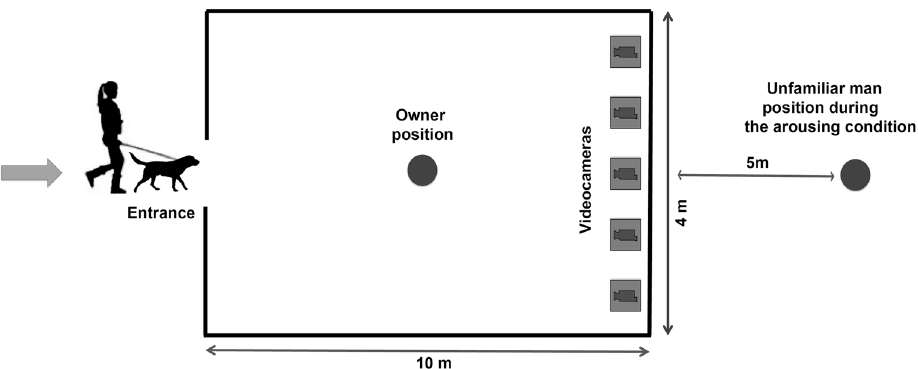
Figure 1. Experimental setup. Schematic representation of the experimental setup used for the recording of dog facial